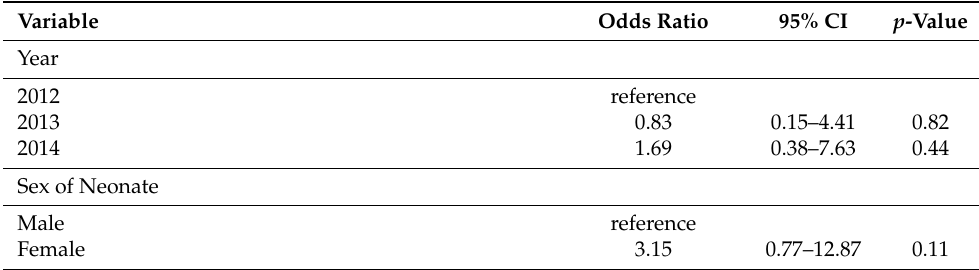
Table 3. Regression model for post-disaster low birthweight (95%